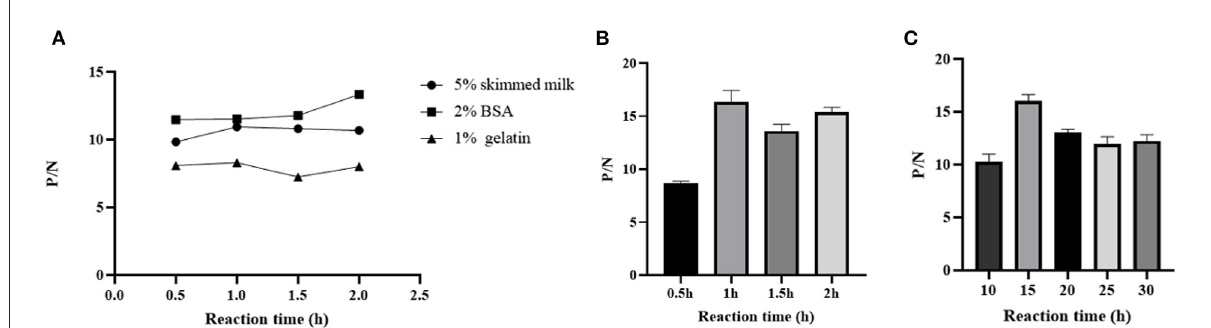
FIGURE2 Optimization of pB602l-ELISA method conditions. (A) Optimization of the type of pB602L-ELISA blocking solution and working conditions. The best blocking solution was 2% BSA in PBST, and optimal blocking conditions are 2h at 37 ◦ C. (B) Determination of serum action conditions. The